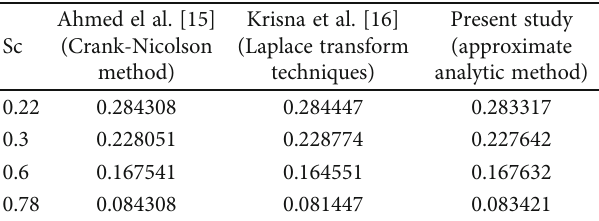
Table 3: Distinct values of H , t , Ec, M , Pr, Sc, F , Gr, Kc, Gc, k when λ = 1 , and m = 1 for the skin friction coe ffi cient ( − u ′ ð 0 Þ ).